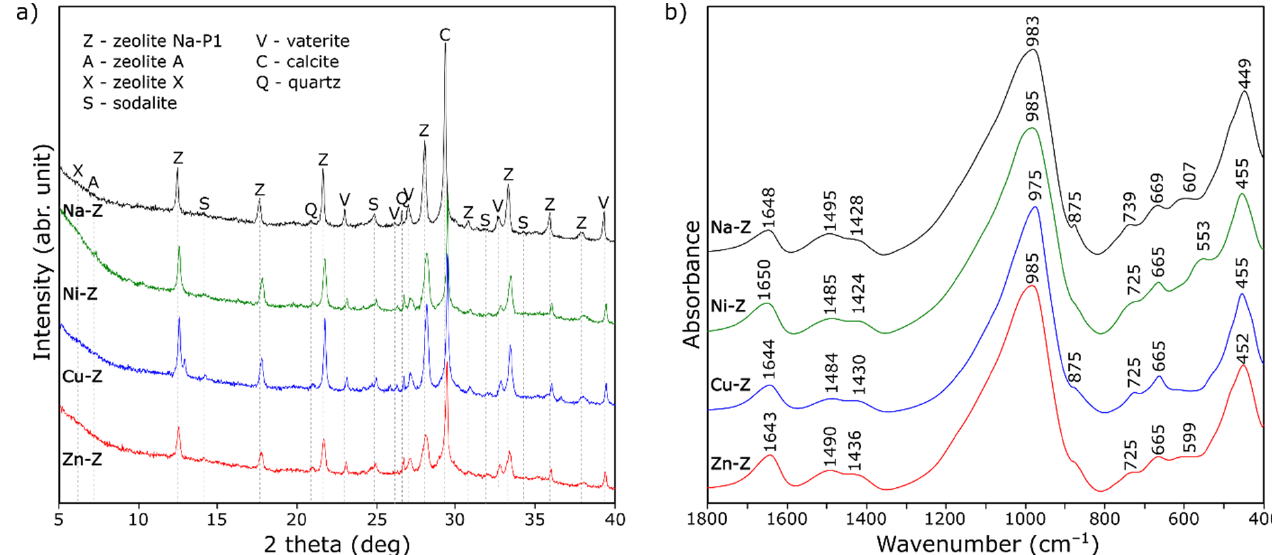
Figure 2. X-ray diffraction patterns ( a ) and FT-IR spectra ( b ) of lightweight aggregate containing zeolite impregnated with various ions.